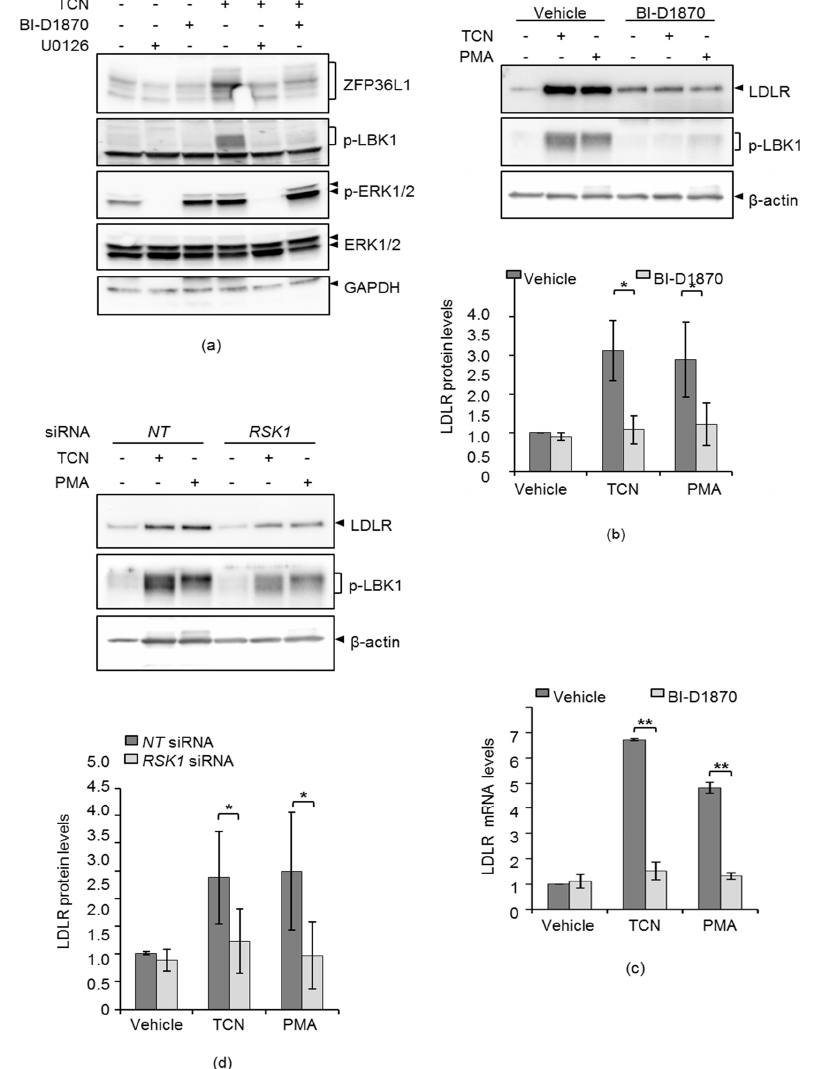
Figure 4. TCN-induced ZFP36L1 phosphorylation is mediated by the ERK downstream target RSK1. ( a ) HepG2 cells were treated with either U0126, BI-D1870 or not for one hour prior to the addition of TCN for four hours. Lysates were immunoblotted with the indicated antibodies. ( b ) HepG2 cells were treated with BI-D1870 or not for one hour prior to addition of TCN for four hours or PMA for one hour. PMA was used as a positive control in this assay. Lysates were subjected to immunoblotting with the indicated antibodies. The graph below the blot depicts the intensity of LDLR after normalization to the β -actin protein, * p < 0.05, n = 3. ( c ) HepG2 cells from a duplicate experiment, as described in ( b ) were harvested and subjected to total RNA-extraction and qPCR of LDLR and GAPDH mRNA, ** p < 0.005, n = 3. ( d ) HepG2 cells were transfected with either a non-targeting control ( NT ) or RSK1 siRNAs. Twenty-four hours post transfection, TCN or PMA were added for four hours and lysate were subjected to immunoblotting using the indicated antibodies. the graph below the blot depicts the intensity of LDLR after normalization to the β -actin protein ( n = 3). Error bars represent standard deviation from the mean. * p < 0.05, n =